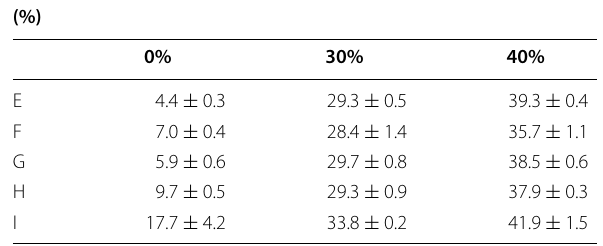
Table 2 Average of rUW at each target value in normal walking conditions